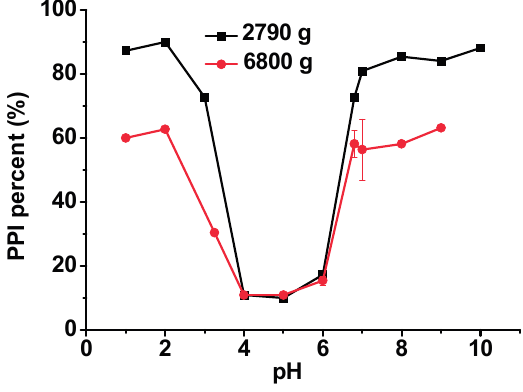
Figure 1. Remaining PPI percentages in different pH solutions after centrifugation at 2790 g or 6800 g for 30